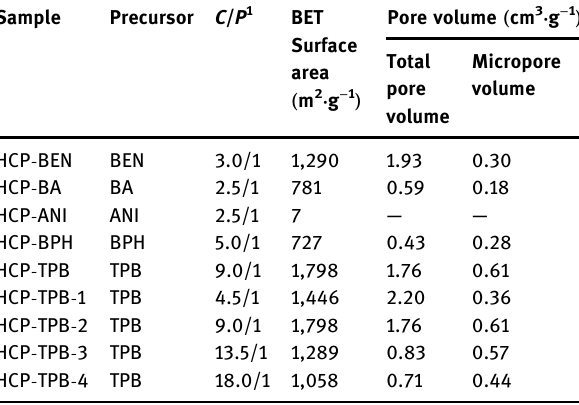
Table 1: Preparation parameters and characterization of the